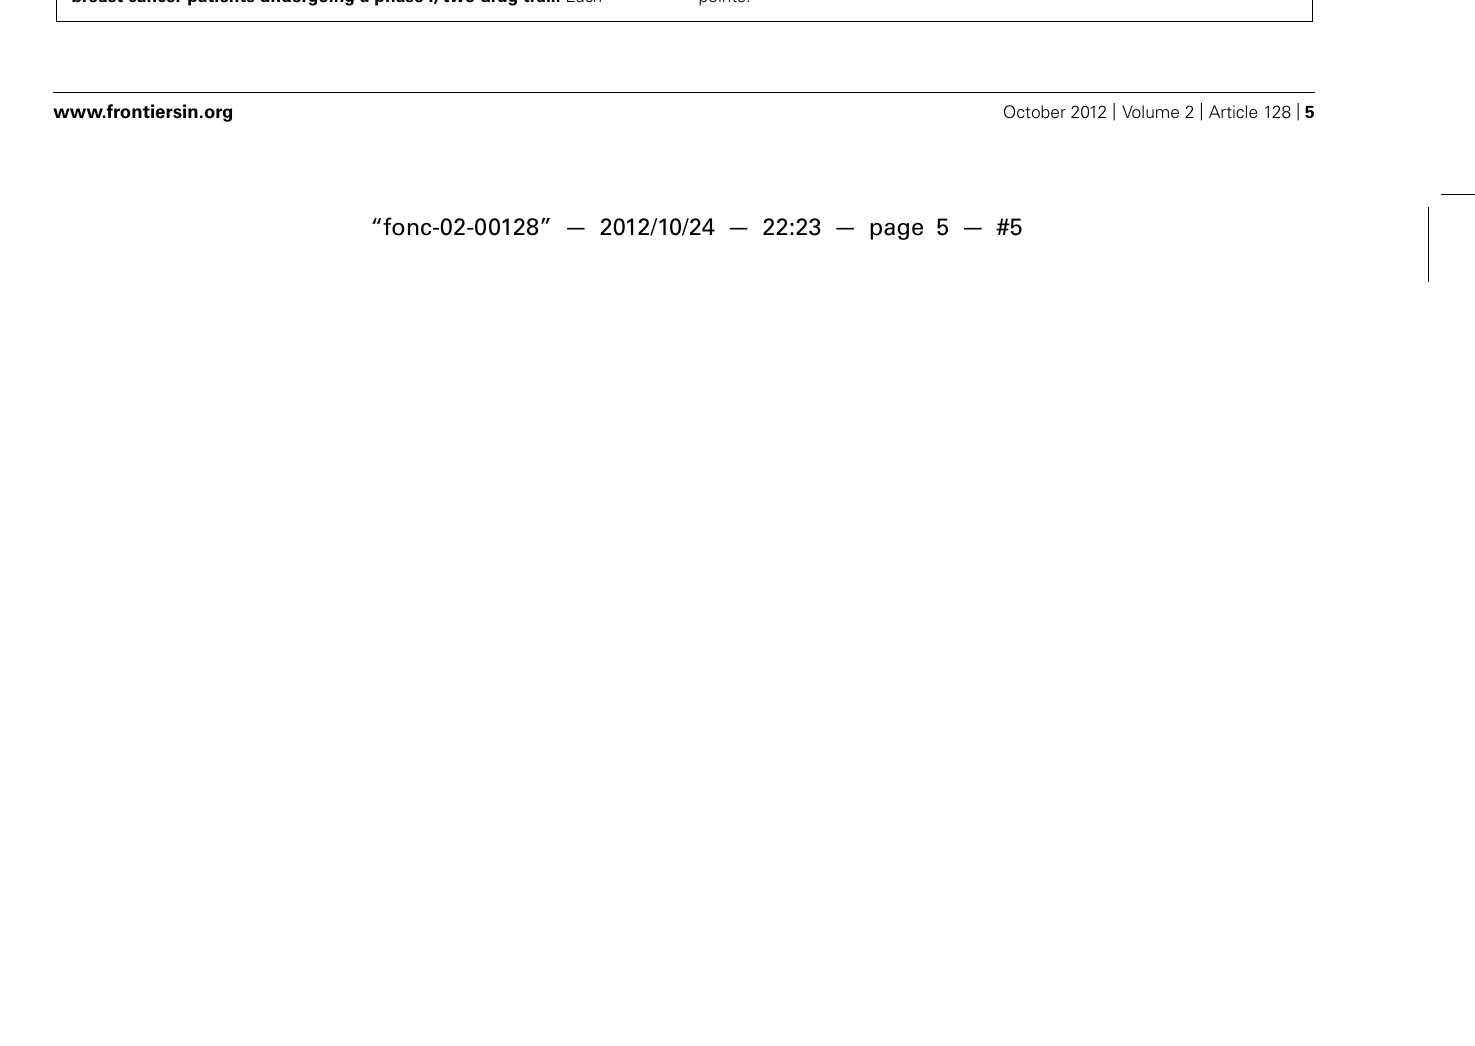
sample was from a different patient; yet these images represent the range of types of cells seen in a majority of patients and time